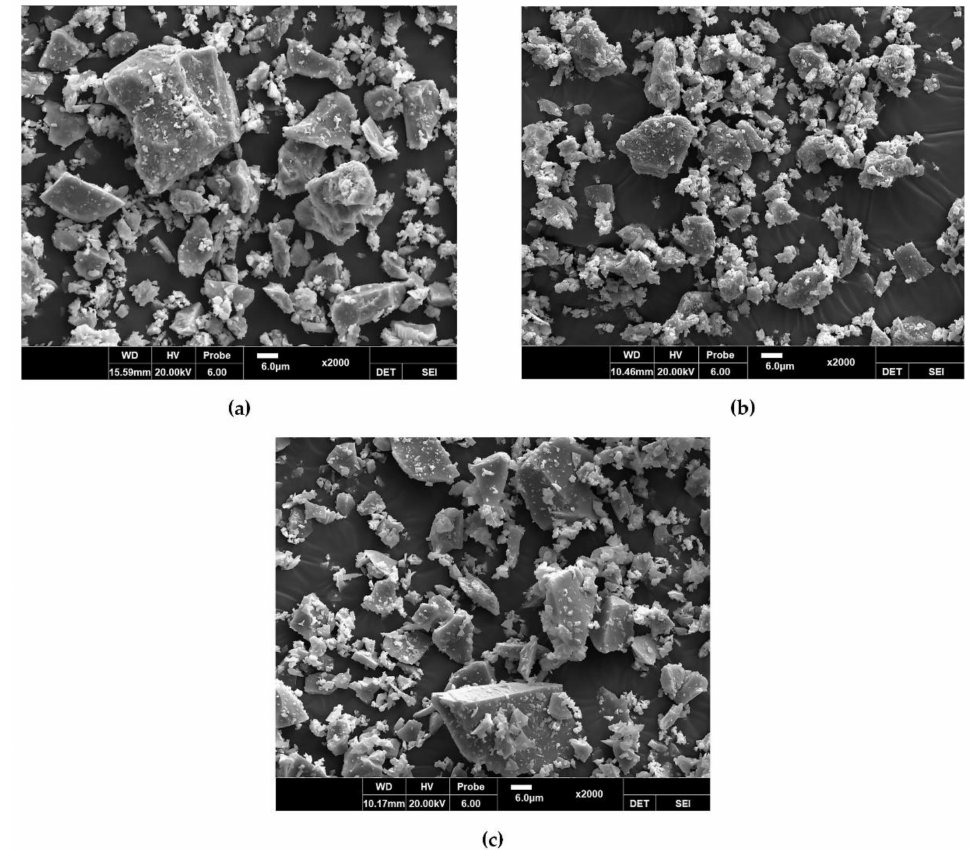
Figure 4. Scanning electron microscope micrograph: ( a ) OPC; ( b ) EPC; ( c ) GGBS.